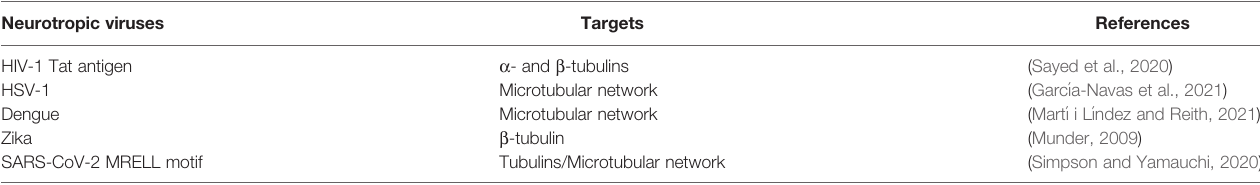
TABLE 2 | Viruses induce immunosuppression and cellular senescence by expressing molecular motifs that mimic physiological fusogens. Neurotropic viruses